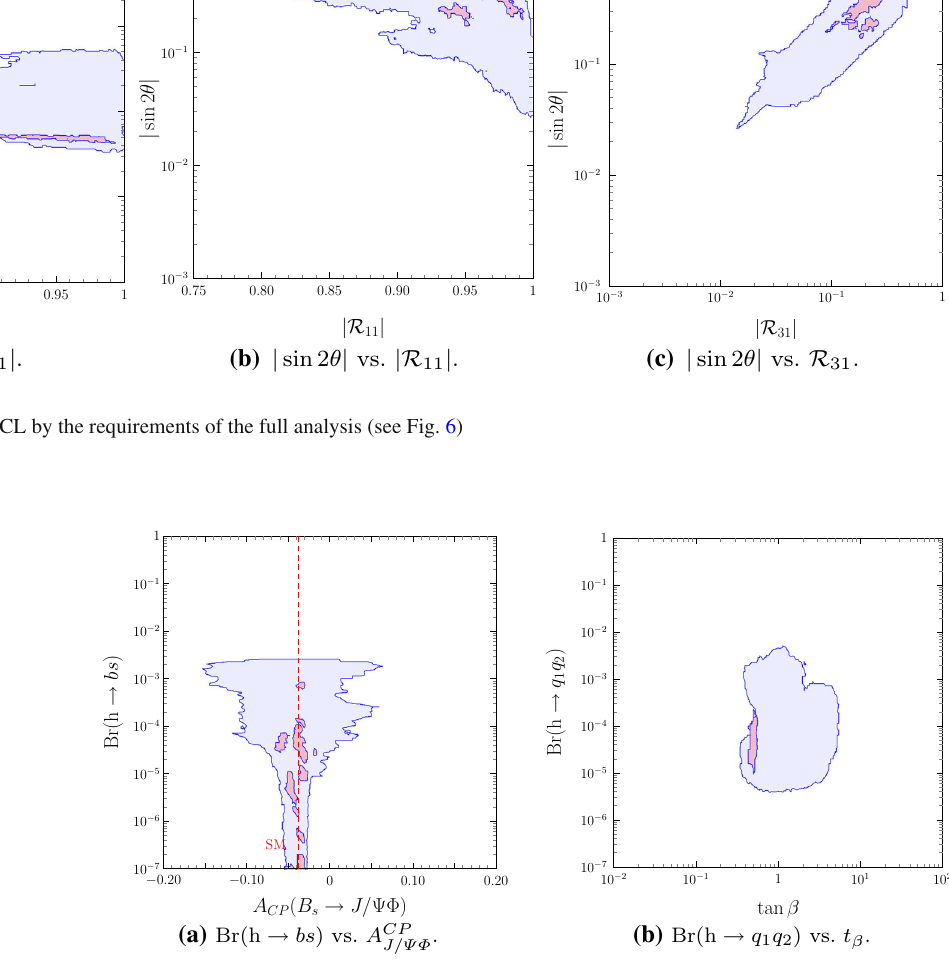
(b) Br(h → q 1 q 2 ) vs. t β